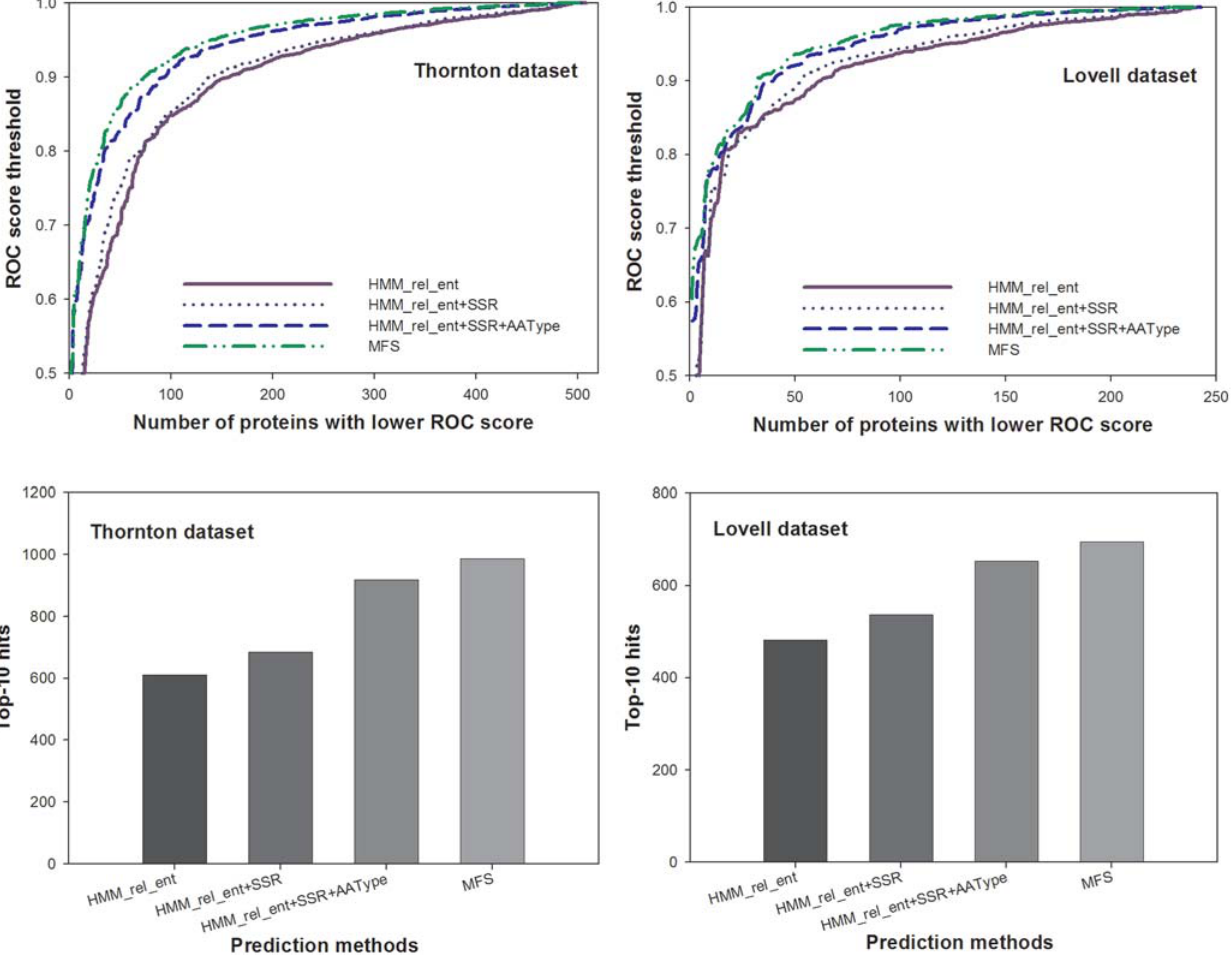
Figure 1. Accuracy of functional site identification in the Thornton and Lovell datasets by several methods that use sequence information only ( HMM_rel_ent ), then with the addition of evolutionary information ( HMM_rel_ent + SSR ), followed by the addition of information on the type of amino acids ( HMM_rel_ent + SSR + AAType ), and finally with the additional structural information (MFS). The ROC scores and the top-10 hits scores were used to evaluate performance. The four methods have increasing accuracy, demonstrating the importance of combining information from sequence, structure, evolution, and amino acid type together when functionally characterizing